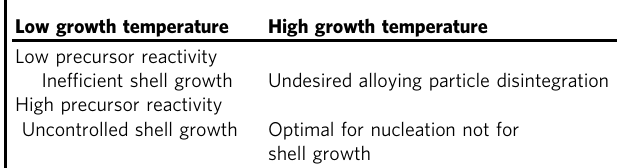
Fig. 4 Detailed processes involved in QD growth. Activated solutes are adsorbed to the surface (i), while the thermal energy of the surface causes surface atoms to be desorbed (ii). The adsorbed atoms are then activated (iii), followed by surface migration and relaxation. The mean-squared diffusion length of adatoms must be long enough to induce defect-free isotropic growth (iv). If the density of activated adatoms is excessive, collision between adatoms quenches surface relaxation, leading to uncontrolled growth (v). The activation energy of step iii (E a3 ) is mainly affected by the reactivity of precursors. In comparison, temperature is the key parameter affecting the activation energy of other steps. Table 1 Summary of the growth results due to suboptimal reaction